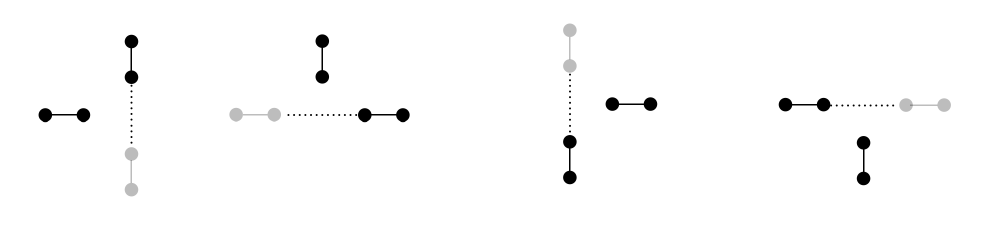
Figure 5: Brading process between dipoles. First we move p y upwards, then p x to the right. Finally p y moves downwards and p x returns to its original